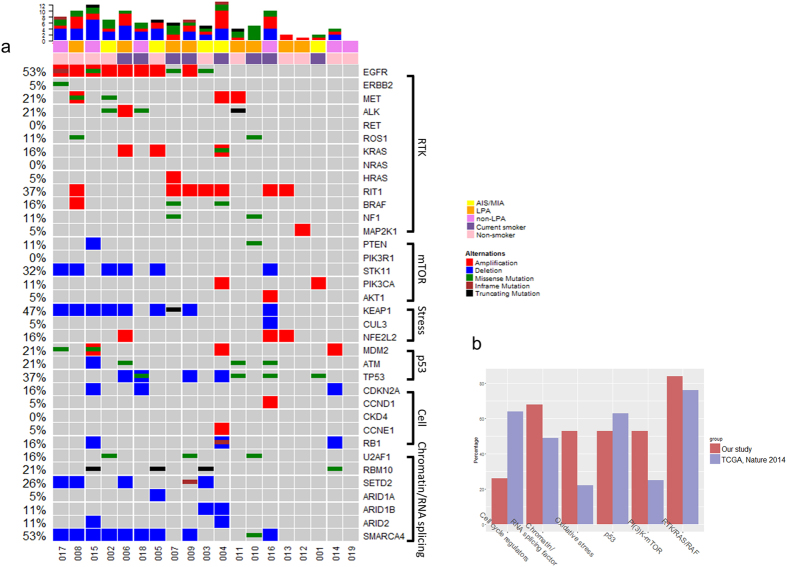
Somatic alteration plots.(a) of genes in multiple key pathways, including genes for lung adenocarcinoma identified in the previous TCGA large-scale sequencing study [8]. Comparative pathway alterations with the large-scale sequencing study are shown (b).